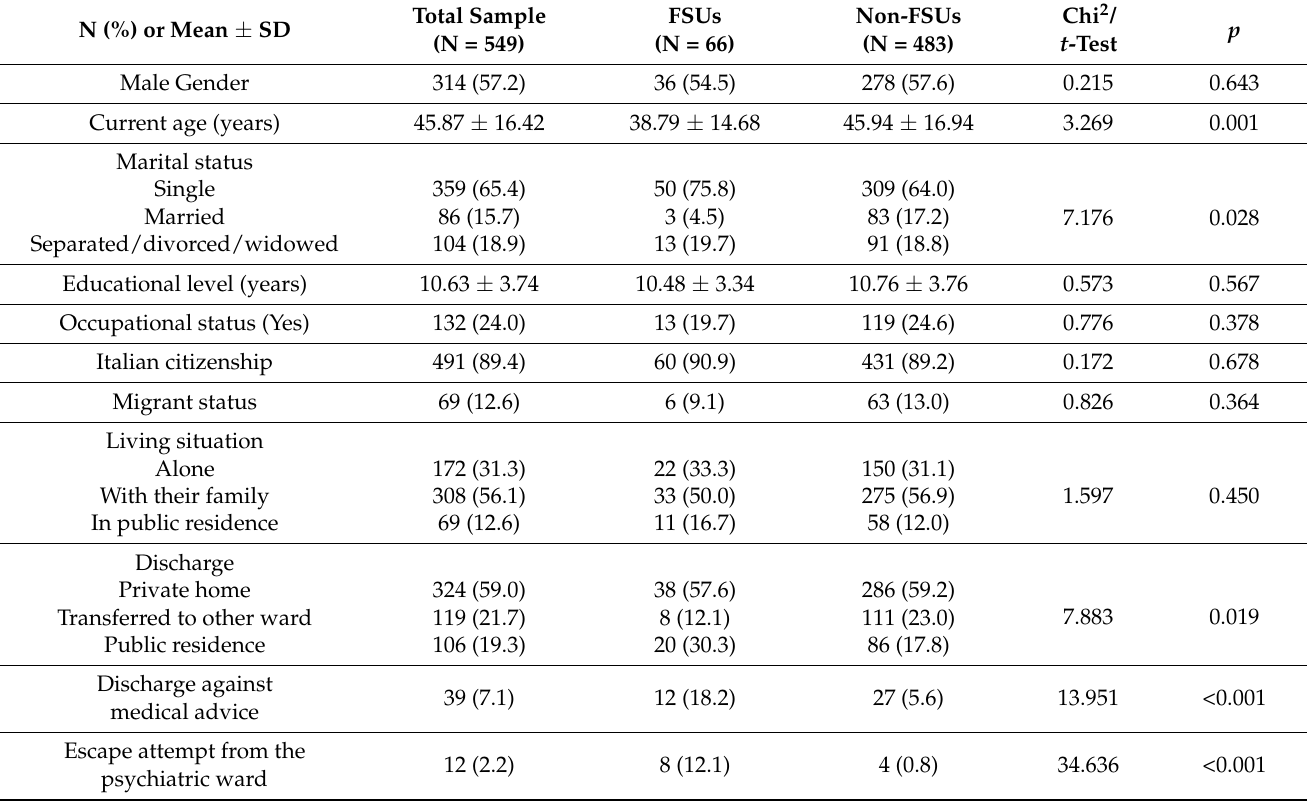
Table 1. Sociodemographic characteristics of the entire sample and of the frequent service users (FSUs) and non-FSUs subgroups.